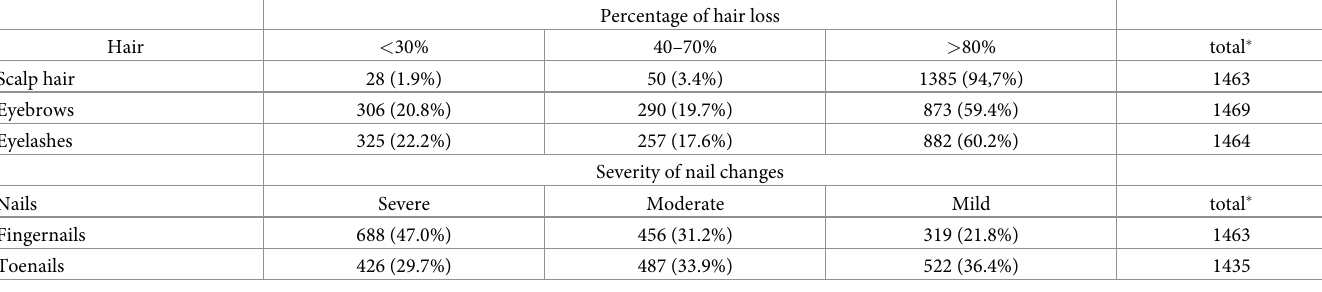
Table 3. Hair loss and nail changes during